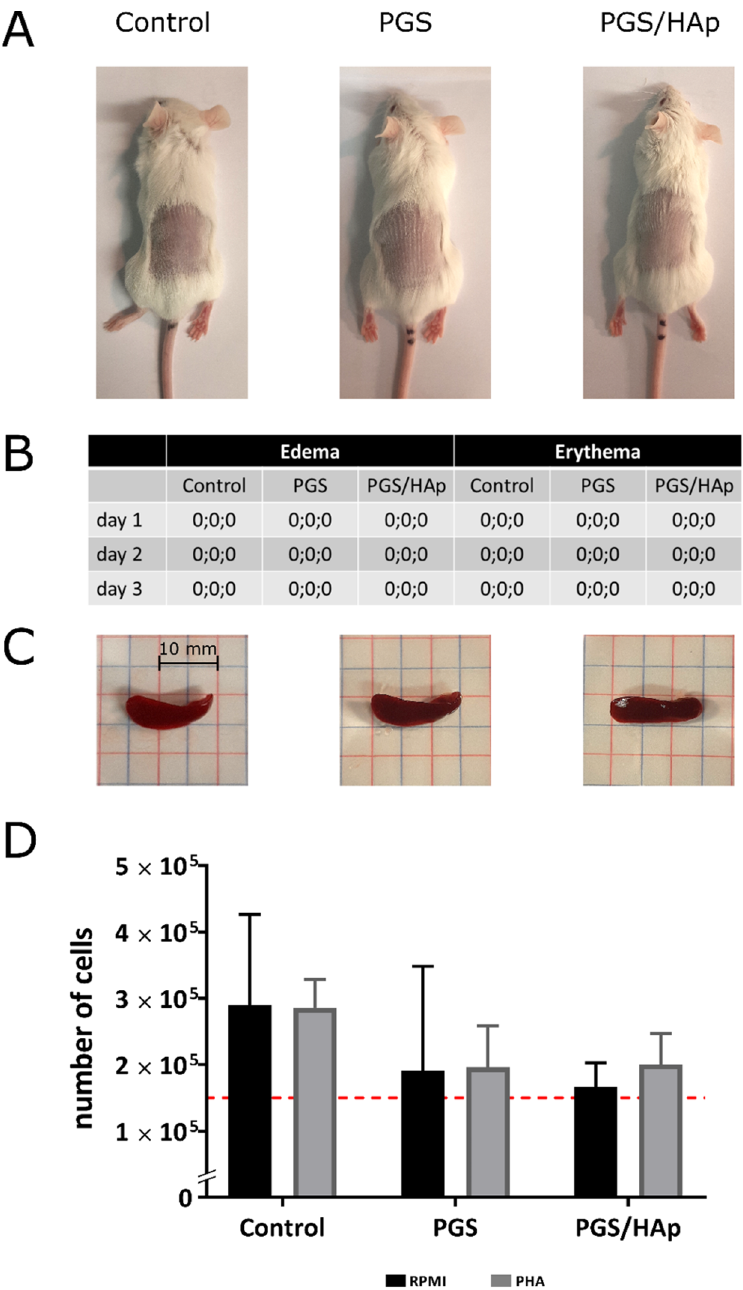
Figure 13. Biocompatibility testing of nonpolar extracts obtained from the PGS and PGS/HAp scaffolds. BALB/c mice were monitored following subcutaneous injections of PGS and PGS/HAp extracts or physiological saline for 72 h to screen for adverse reactions ( A ). The appearance of edema and erythema was assessed and graded daily according to the Primary Irritation Index (PII) = 0/3, where 0 indicates that the irritation is negligible ( B ). At 72 h post-injection, the animals were terminated and spleens ( C ) along with blood, samples and other critical organs were collected and inspected. Splenic lymphocytes were next isolated, and their proliferation rates were measured in the presence or absence of a mitogen—PHA ( D ) with a CyQUANT assay.